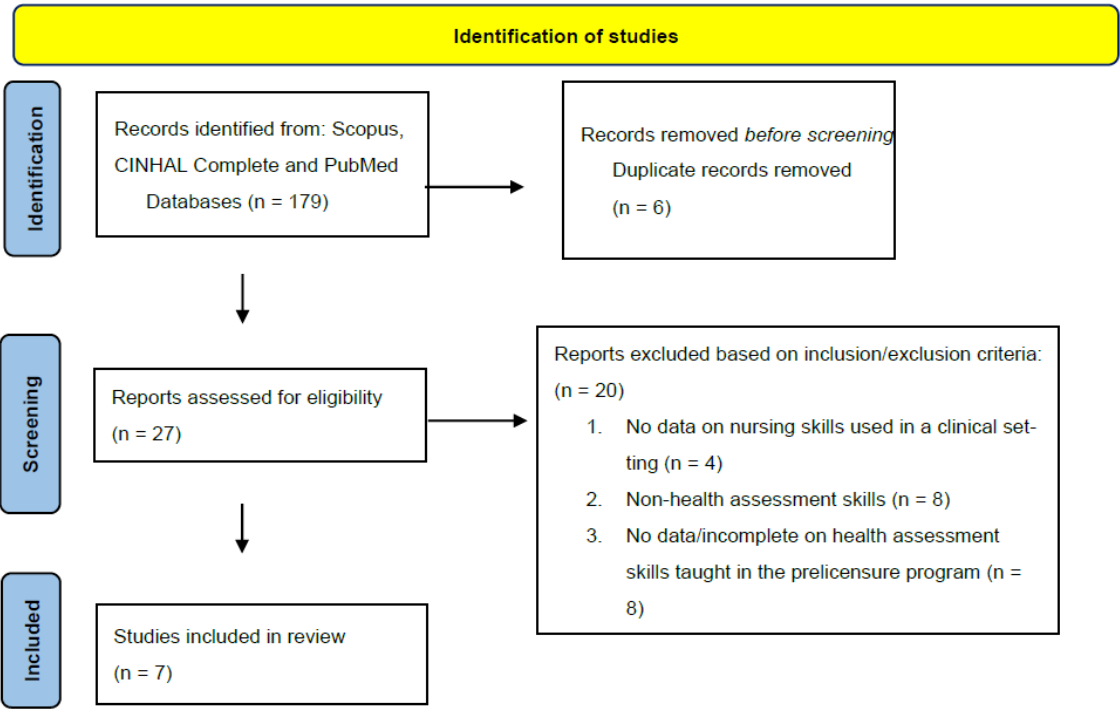
Figure 1. Literature